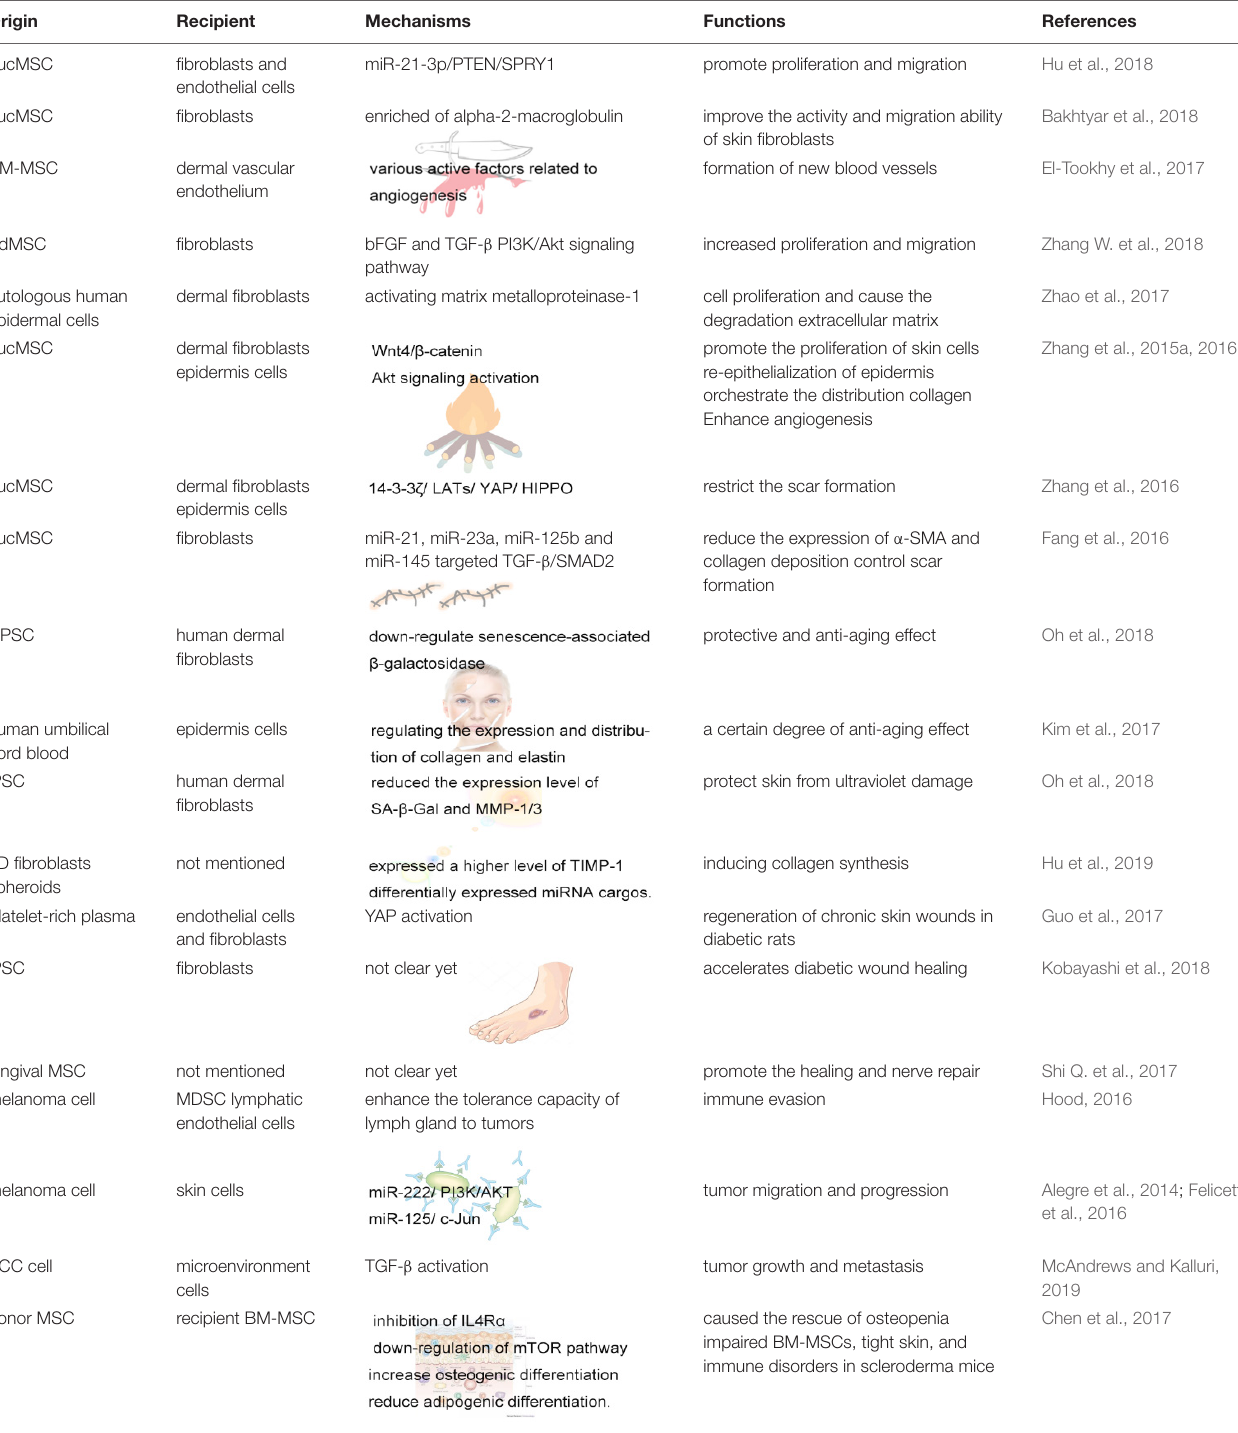
TABLE 2 | Functions of exosomes derived from different origin in cutaneous